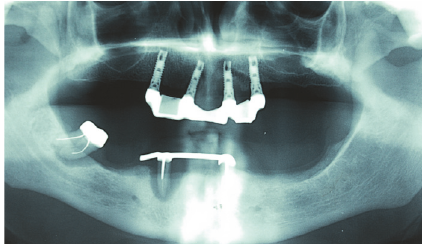
Figure 1: Panoramic radiograph showing periapical lesions related to the right mandibular second molar and canine and the left mandibular canine.